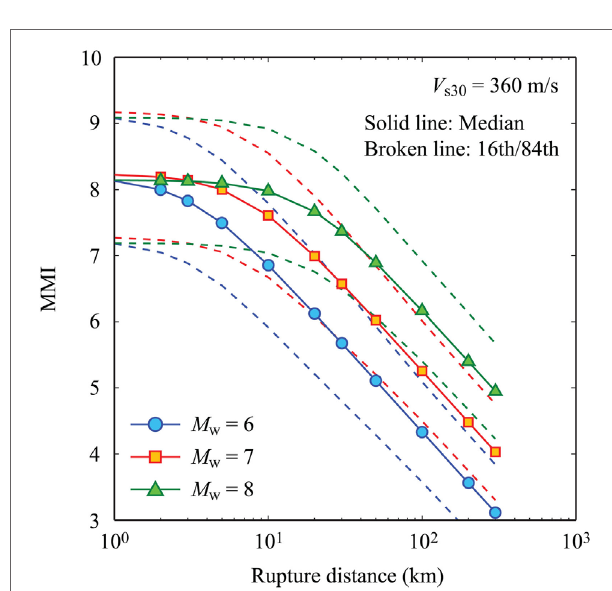
FigUre 6 | MMi prediction model by allen et al. (2012) .